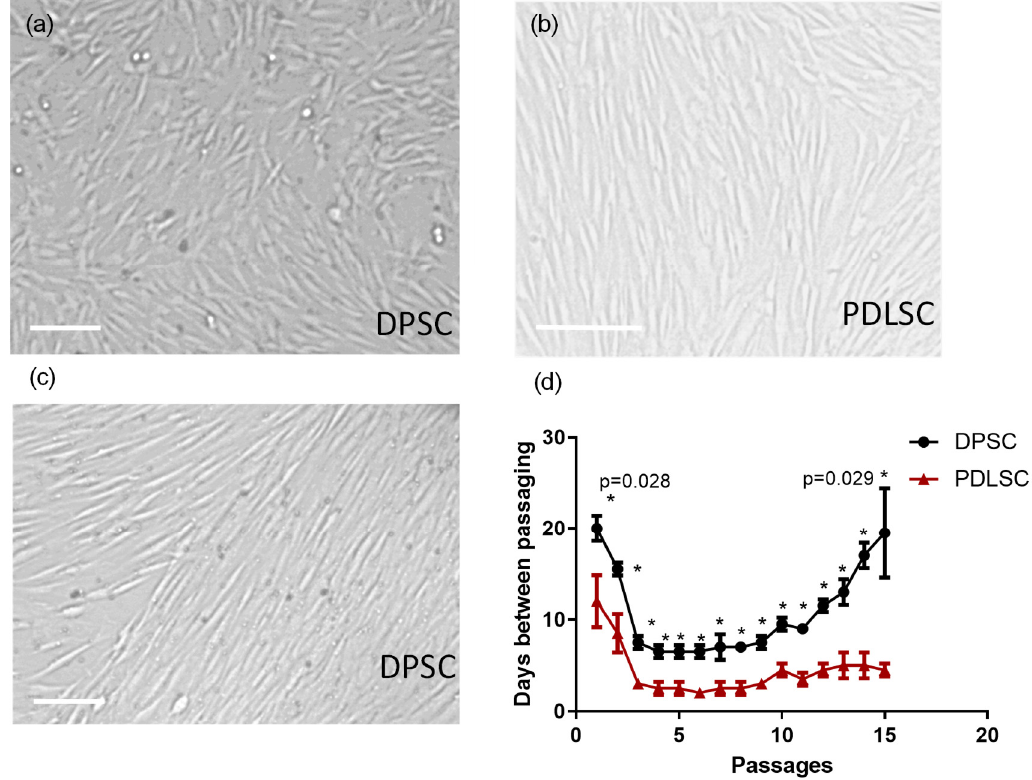
Figure 1. Dental pulp stem cells (DPSC) and periodontal ligament stem cells (PDLSC): morphology ( a – c ), proliferation rate and maximal period of growing in vitro ( d ). ( a ) Irregularly shaped DPSC, ( b ) Spindle-like PDLSC, ( c ) Spindle-like DPSC. ( d ) Time between passaging of DPSC and PDLSC cultures. X -axis—number of passages, Y -axis—days between passages, *—significant ( p < 0.05) difference between PDLSC and DPSC at the same passage (the exact p -value is given for the first and last passages). Scale—50